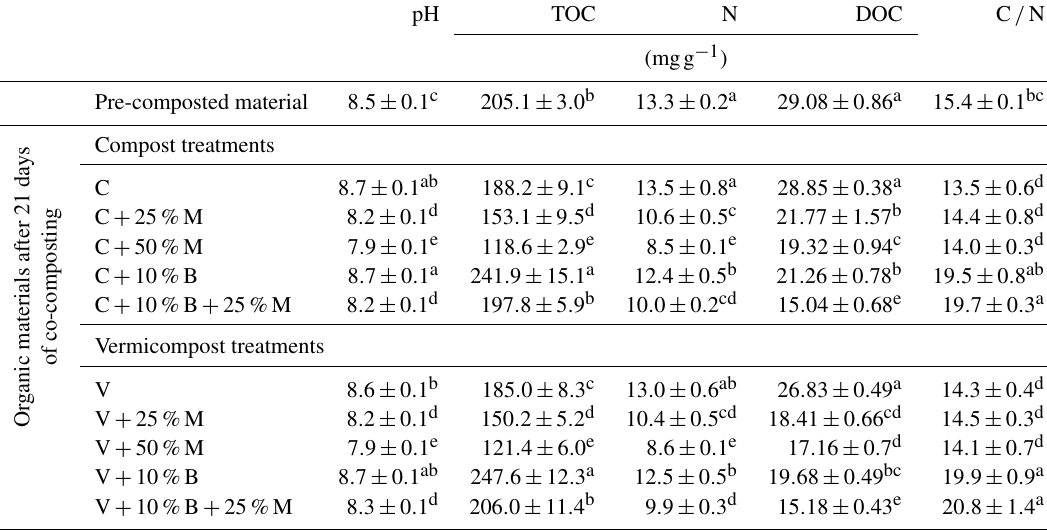
Table 1. Mean values of pH, total nitrogen, total organic carbon (TOC) and dissolved organic carbon (DOC) after 21 days of co- (vermi)composting. Data are presented as means and standard error ( n = 4). Different small letters indicate significant differences between treatments (Kruskal–Wallis test, p < 0.005). C: compost; V: vermicompost; B: biochar; M: clay. Data with different small letters indicate significant differences between treatments. pH TOC N